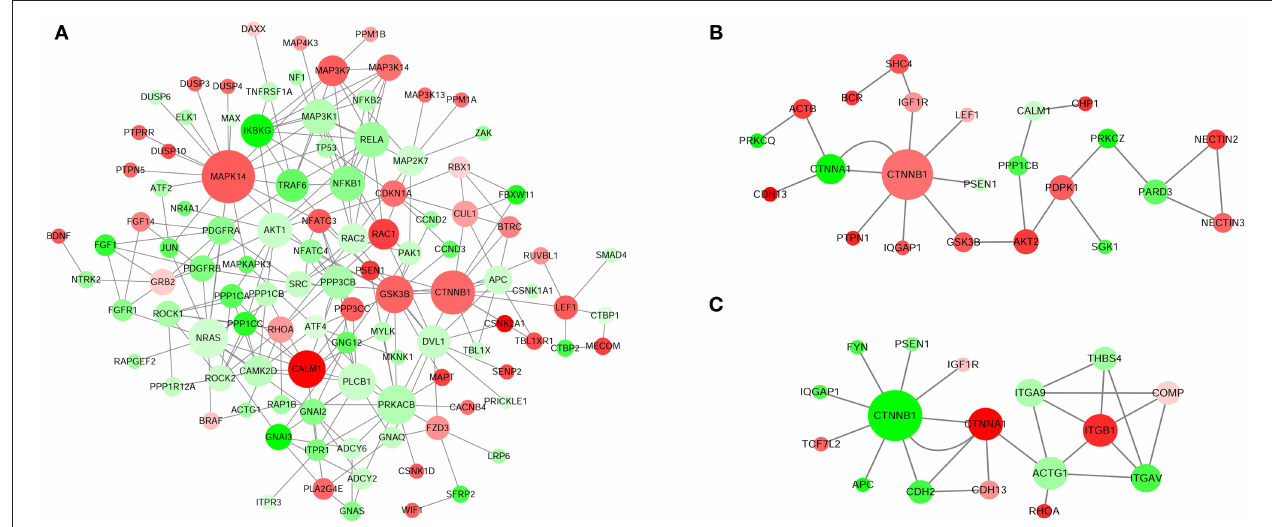
FIGURE 2 | Interaction networks of top DE unigenes in each comparable group. (A) Tst_2 vs. Tst_1. (B) Tst_3 vs. Tst_2. (C) Tst_4 vs. Tst_3. The up-regulated unigenes were displayed as red circles, and the down-regulated unigenes were displayed as green circles.